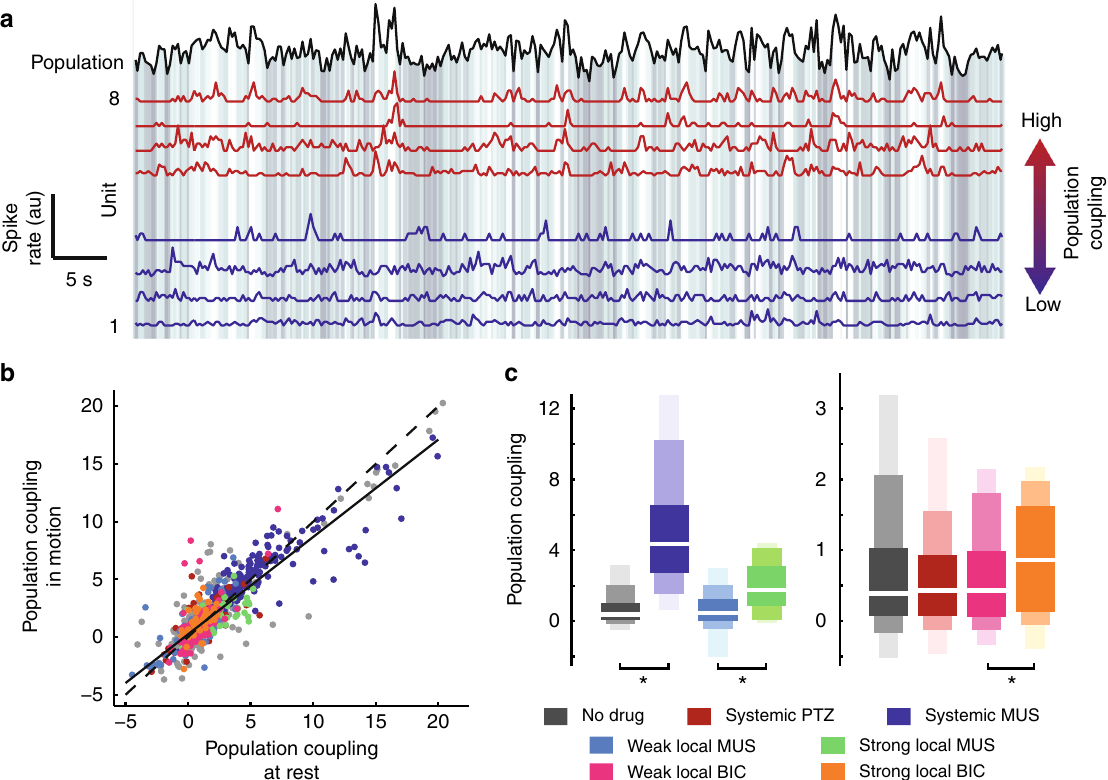
Fig. 2 Minimal population coupling for unaltered inhibition. a Spike count time series for the collective population activity (black, summed over all units) and eight example single units (red — high population coupling; blue — low population coupling). Background grayscale indicates the population spike rate. b Population coupling during periods of rest is slightly higher, but strongly correlated with population coupling during motion. Each point represents one unit. Dashed line indicates equality. Solid line indicates best linear fi t. Color indicates inhibitory condition as in c . c Enhancing inhibition results in more neurons with high population coupling, whether the manipulation was systemic or local. Locally reducing inhibition also increased population coupling. In general, unaltered inhibition resulted in minimal population coupling, averaged over